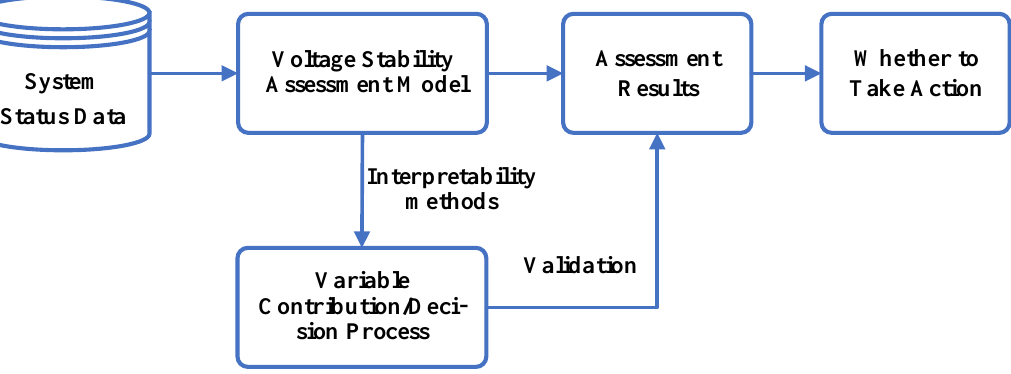
Figure 2. The general idea of interpretable ML for voltage stability